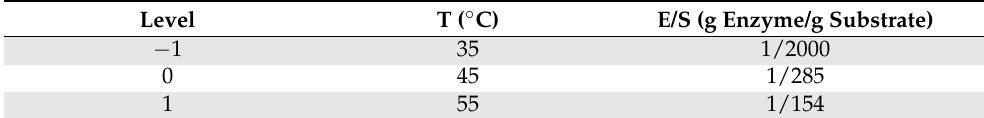
Table 1. Codification of operating condition parameters.